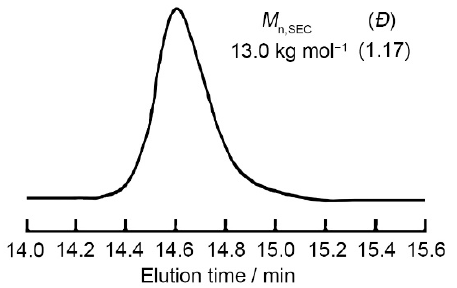
Figure 2. SEC trace of poly(iPMAm 85 - stat -PDMAm 15 ).